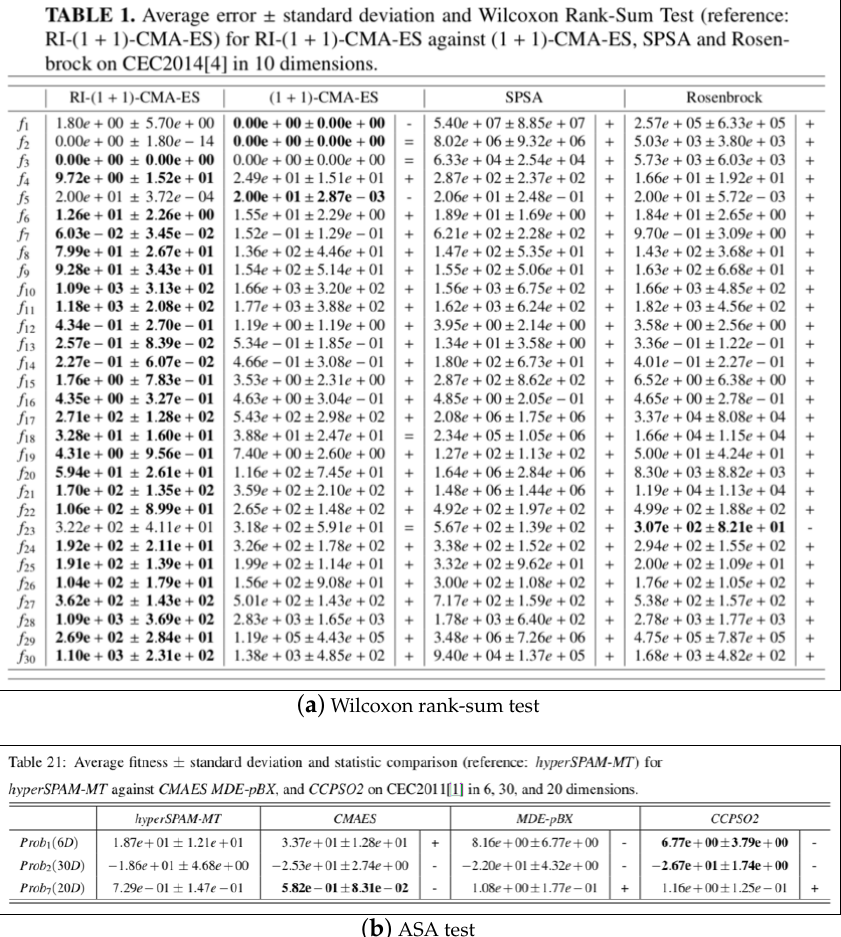
Figure 10. Two examples of TableAvgStdStat tables based on the Wilcoxon rank-sum test ( a ) and the ASA test ( b ), respectively. In ( a ), some results from the study in [73] obtained over the functions of the CEC 2014 benchmark suite [2]. In ( b ), some from the study in [24] obtained over three real-world problems from the CEC 2011 benchmark suite [42]. Extended results for the studies in ( a , b ) are available in the repository